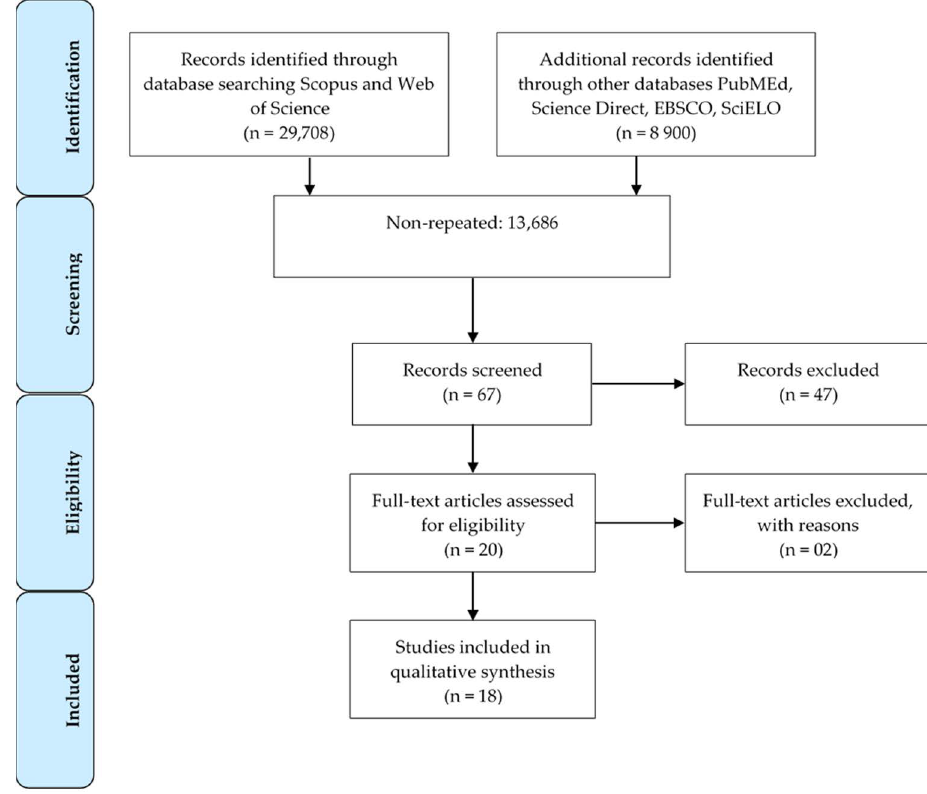
Figure 4. Stages of the search and selection process. Table 4. Characteristics of the selected studies.